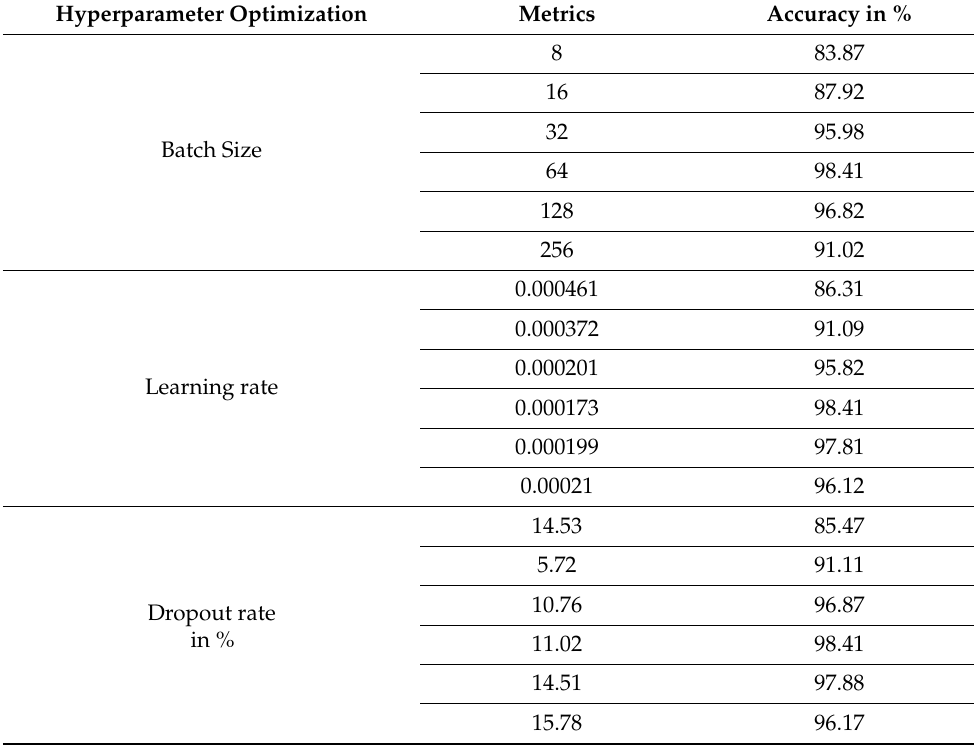
Table 4. Results of hyperparameter